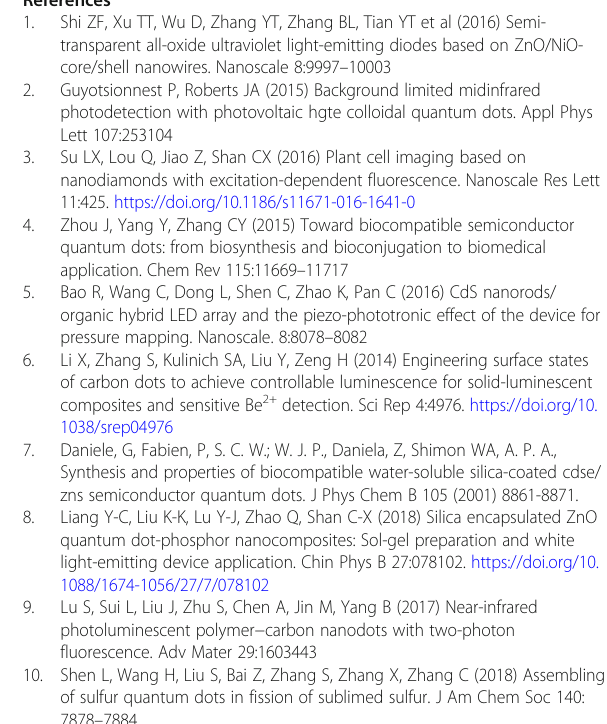
Additional file 1: Figure S1. Change of soybean solution before and after ultrasonic extraction treatment. Figure S2. (a) UV-Vis absorption and PL spectra of the NBDs by UES from mung bean. (b) XRD pattern. (c) FTIR spectrum. (d) XPS of the NBDs. Figure S3. Fluorescence and excitation spectra of the as-prepared NBDs. Figure S4. The PL spectra of the soybeans during ultrasonic extraction. Figure S5. The images of the NBD powders under UV illumination (0.15mW/cm2) and corresponding testing process. Figure S6. The photostability of the NBDs after irradiation for 6h. Figure S7. The thermostability of the NBDs at different temperatures. Figure S8. Absorption spectra of the NBDs with Fe 3+ and without Fe 3+ . (DOCX 1231 kb)